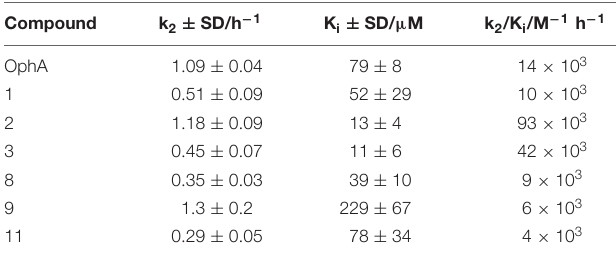
TABLE 3 | Analysis of K i and k 2 and the second-order rate constant k 2 /K i from data plotted in Figure 2 and processed as described.